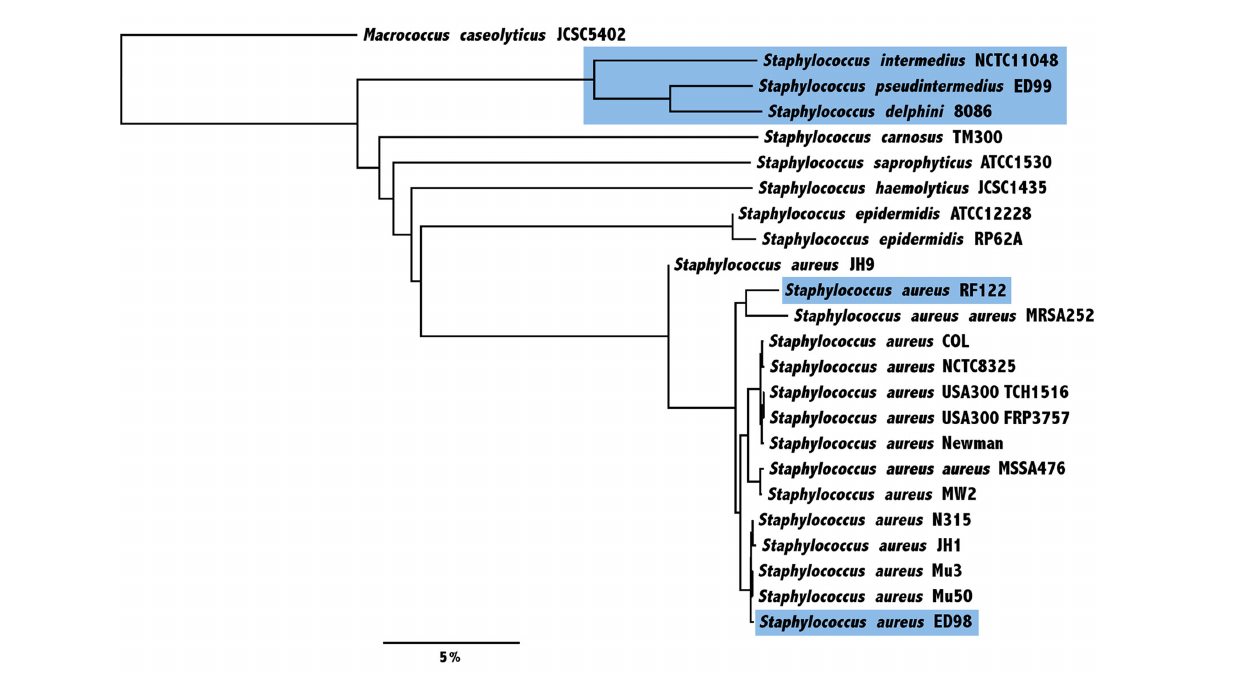
relatedness was examined by calculation of ANI, based on core genes only. Species and strains of animal origin are highlighted in blue (scale indicates the % difference